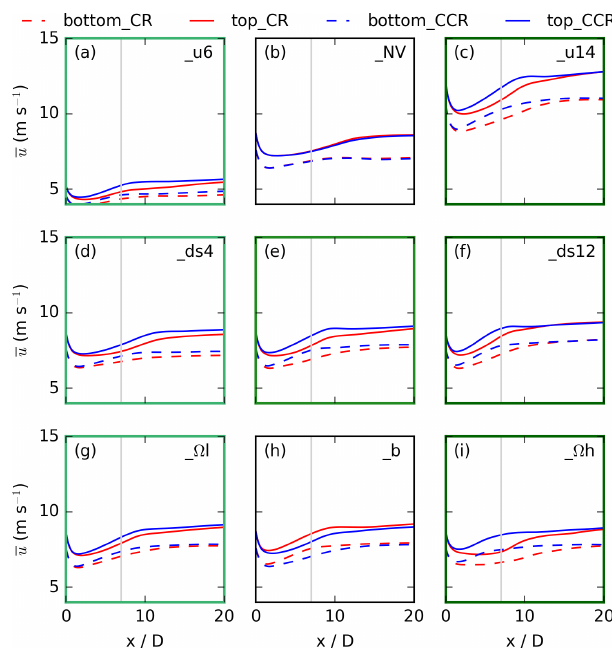
Figure 19. Sector averages of u representing the top and bottom 90 ◦ sectors for 0m < r ≤ 50m for clockwise- and counterclockwise-rotating actuators for the same simulations as in Fig.